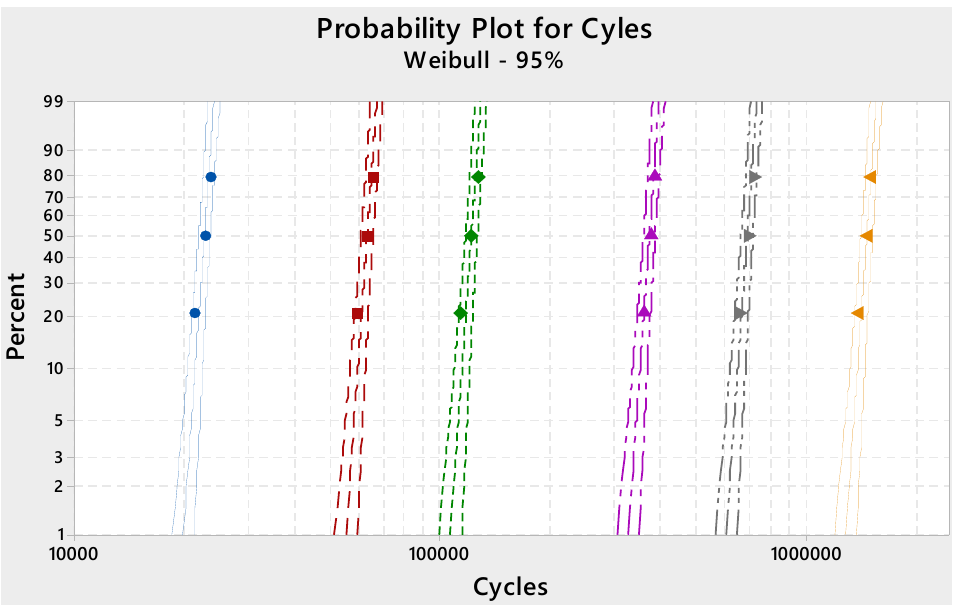
Figure 5. Acceleration verification of fatigue life.